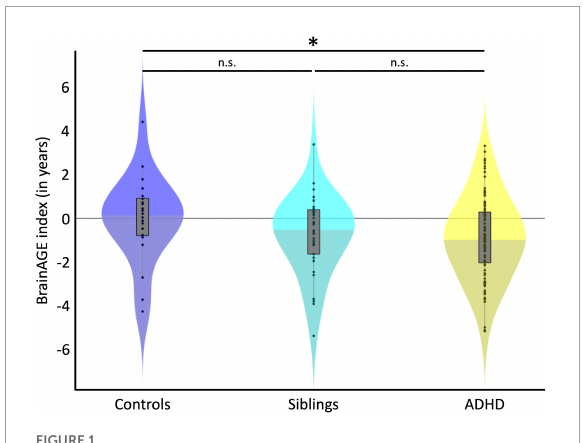
FIGURE1 Group Differences. Violin plots depict the BrainAGE distribution for each group. The black dots show individual estimates, the gray boxes show the group-specific interquartile ranges, and the whiskers show the group-specific 1.5 interquartile ranges. Shading for each group’s violin plot changes at the median. On average, children with ADHD (yellow) were estimated significantly younger than control children (blue), as indicated by the asterisk. Siblings unaffected by ADHD (cyan) were also estimated younger than control children (blue), but this difference did not reach statistical significance